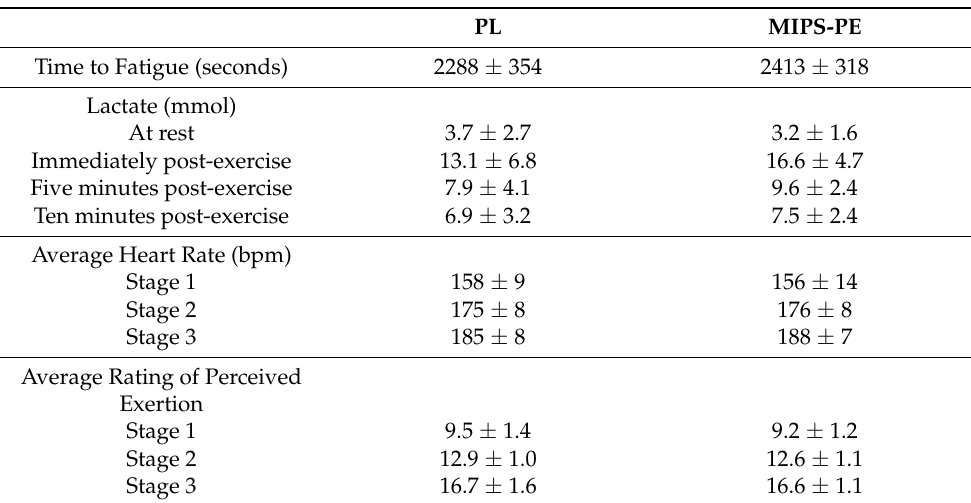
Table 1. Summary data for recorded variables. Data are presented as mean ± SD. PL